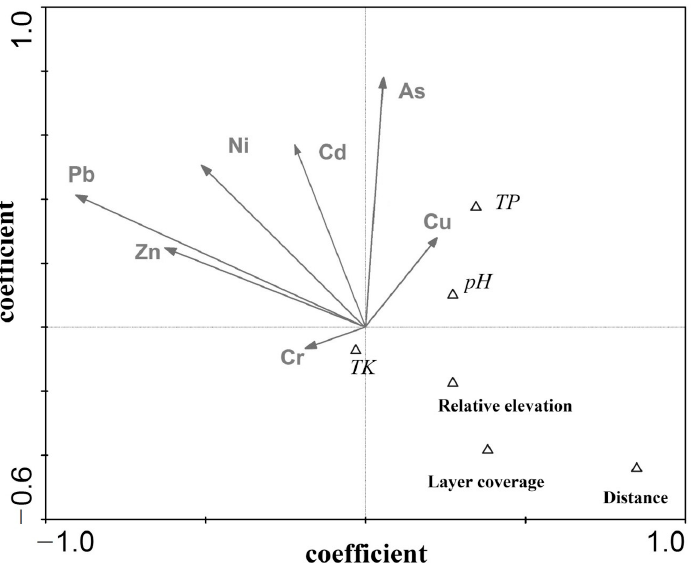
Figure 3. Ordination diagram resulting from CCA on soil heavy metals with influencing